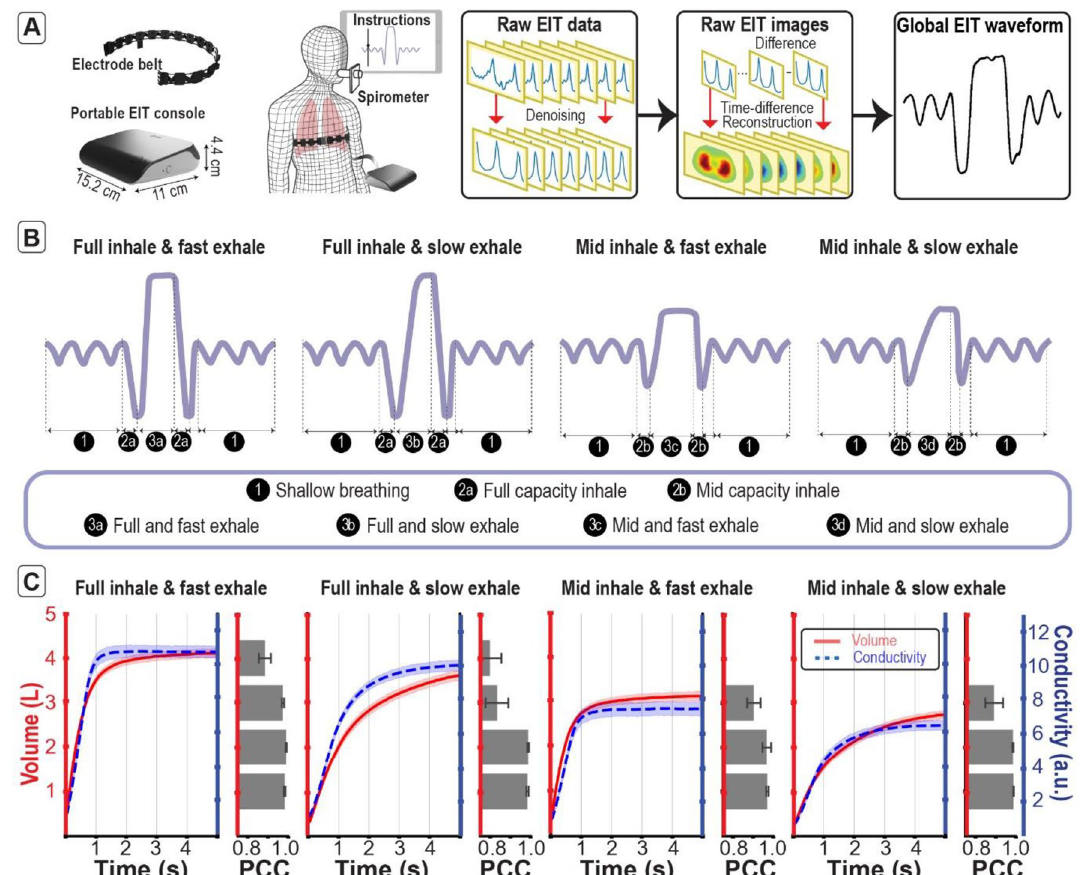
Figure 1. The portable EIT system and its data processing pipelines extracts conductivity-time curves that are highly correlated with the volume-time curves under different breathing paradigms. ( A ) The EIT system consists of a portable console, electrode belt, mobile app interface, and cloud-based processing pipeline. Raw EIT data is first acquired followed by denoising, time-difference EIT image reconstruction, and global conductivity waveform extraction. ( B ) Simultaneous EIT and spirometry were applied with four different breathing paradigms, including a combination of full or mid capacity inhale, and fast or slow exhale. ( C ) The mean (± standard error) of the extracted global conductivity-time curve and the volume-time curve agree as shown by the bar plots of the Pearson’s correlation coefficient (PCC; ± standard error) computed on the volume segments 0-1L, 1-2L, 2-3L, and 3-4L. The drawings of the electrode belt and the portable EIT console were made using Dassault Systemes Solidworks 2020, Luxion Keyshot 9 and Adobe Photoshop CC 2019. The drawings of the dummy person and spirometer were made using Adobe Illustrator